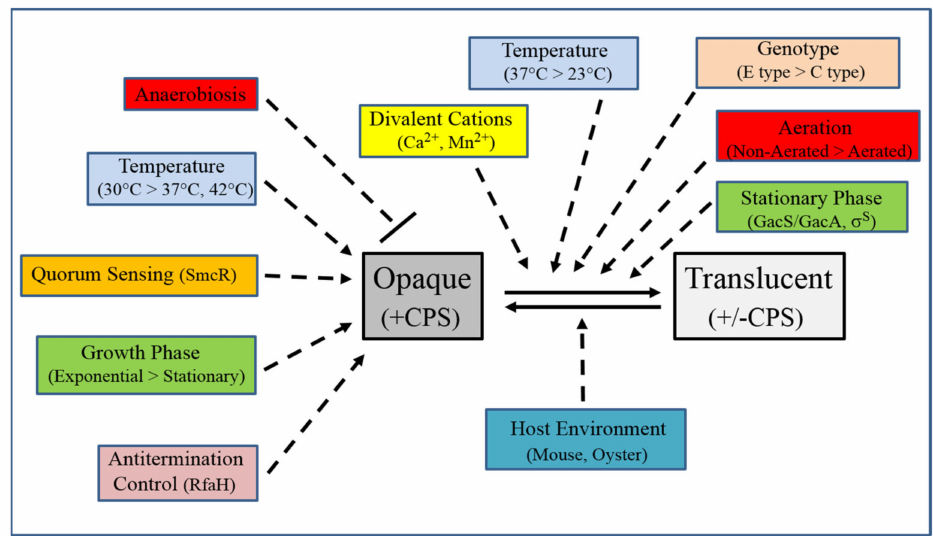
Figure 3. Summary of known environmental, genetic, and regulatory factors that a ff ect CPS production in V. vulnificus . CPS production in opaque variants is negatively a ff ected (depicted by dashed line with bar) by anaerobiosis [42], but positively a ff ected (dashed arrows) by lower growth temperature [51,56], quorum sensing as mediated by SmcR [55], exponential growth [51], and antitermination control via RfaH [59]. Phase switching from opaque to translucent (solid arrow) is positively a ff ected by divalent cations Ca 2 + and Mn 2 + [43,44], higher growth temperature [40], E-type genotypes [40], non-aerated growth [40], and stationary phase growth, with the latter e ff ect potentially being mediated by GacS / GacA and σ S [48]. Host environments such as mouse [11] and oyster [45] promote phase variation from translucent to opaque, but to what extent, if any, the rate of phase switching is a ff ected by these environments remains to be determined. See text for more details regarding these various